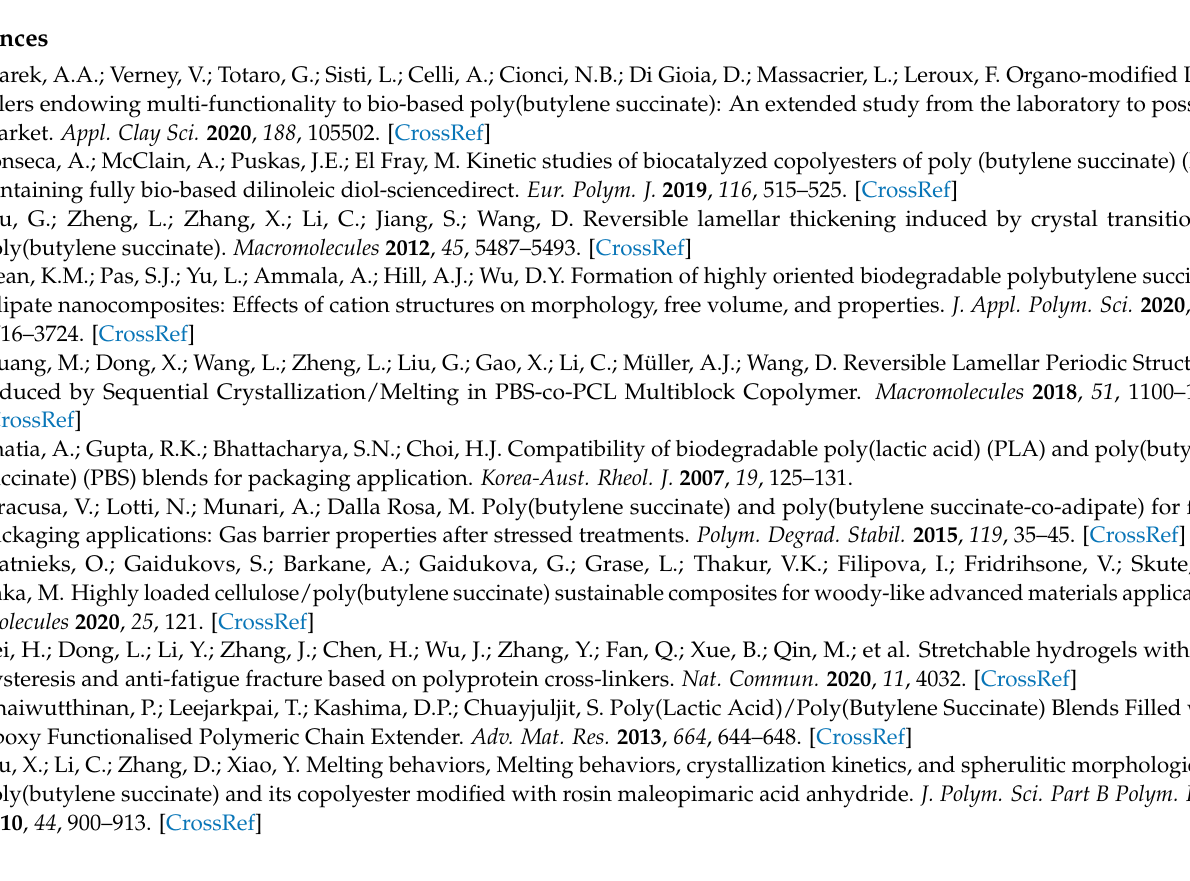
Table S1: Mechanical properties and Carreau-Yasuda model constants for PBS and PBS composites; Table S2: Parameters of PBS and PBS composites obtained from non-isothermal crystallization at a cooling rate of 10 ◦ C min − 1 ; Video S1: The notched tension of the virgin sample and the chain extension